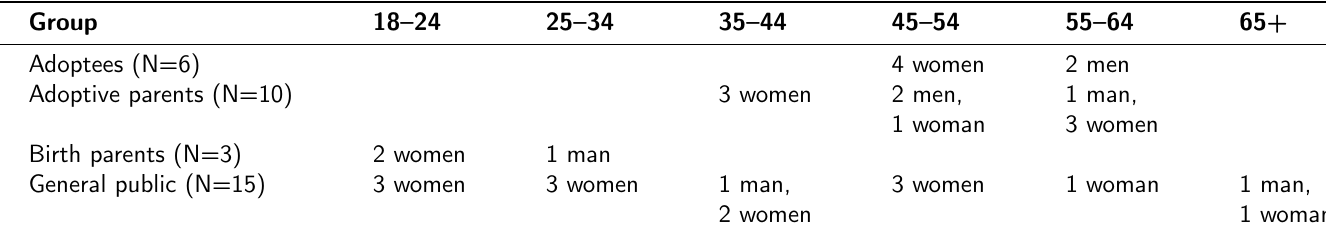
Table 1: Age and sex of individuals who participated in the